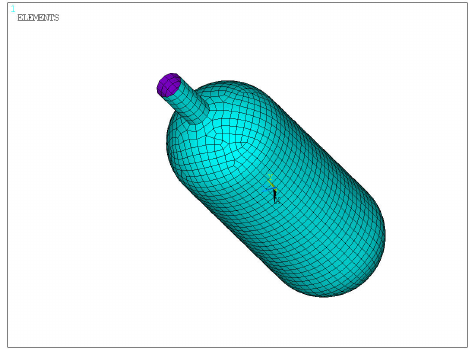
Figure 2. Model grid diagram.